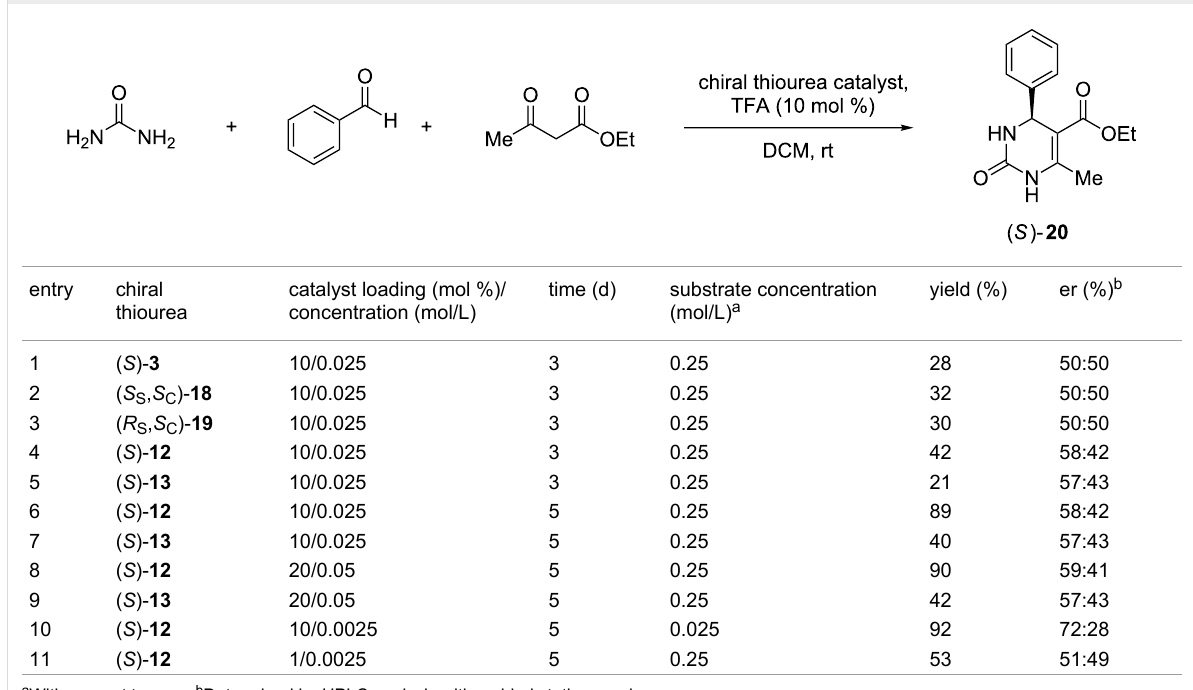
Table 1: Evaluation of the sulfonimidoyl-containing thiourea organocatalysts in the asymmetric Biginelli reaction to afford scalemic dihydropyrimidi- none ( S )- 20